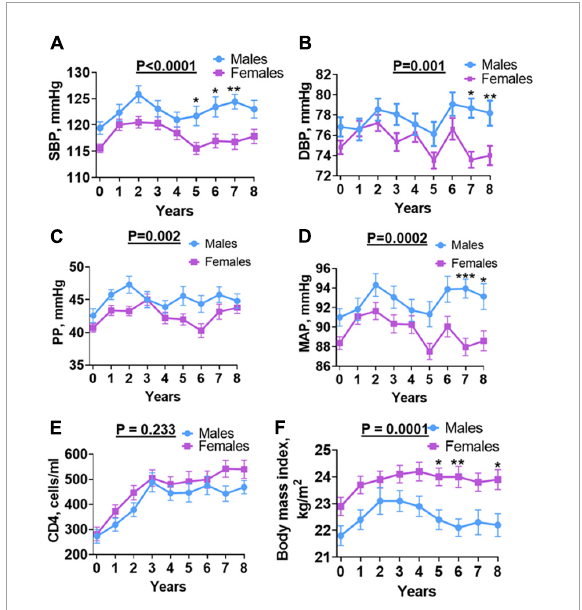
FIGURE3 Sex differences in BP, CD4, and BMI over time. (A) SBP, (B) DBP, (C) PP, (D) MAP, (E) CD4 absolute count and (F) body mass index: shows changes in individual parameters each year for 8 years from baseline (before antiretroviral therapy) until final (after antiretroviral therapy) for males and females. SBP, systolic blood pressure; DBP, diastolic blood pressure; PP, pulse pressure; MAP, mean arterial pressure; Welch’s test was used to compare means between males and females. Asterisks indicate a time point with significant differences in blood pressure between males and females. * p < 0.05; ** p < 0.01; *** p <